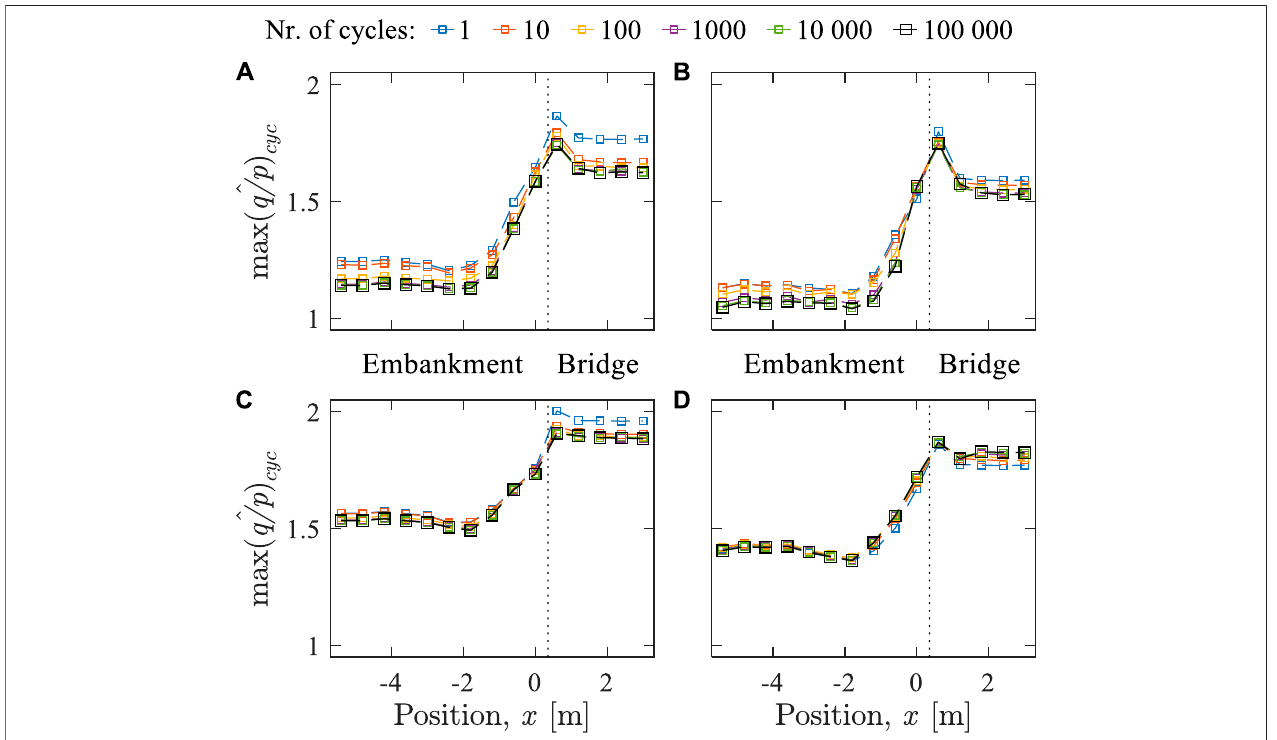
FIGURE 14 | Change in maximum ratios ( (cid:17) q / p ) cyc with N, at positions (A – D) in the ballast layer.